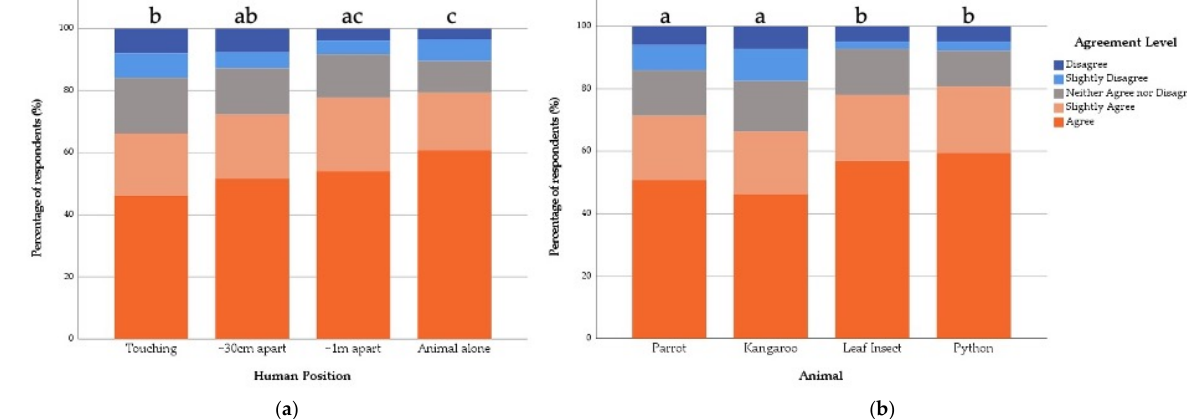
Significant results are highlighted in grey.